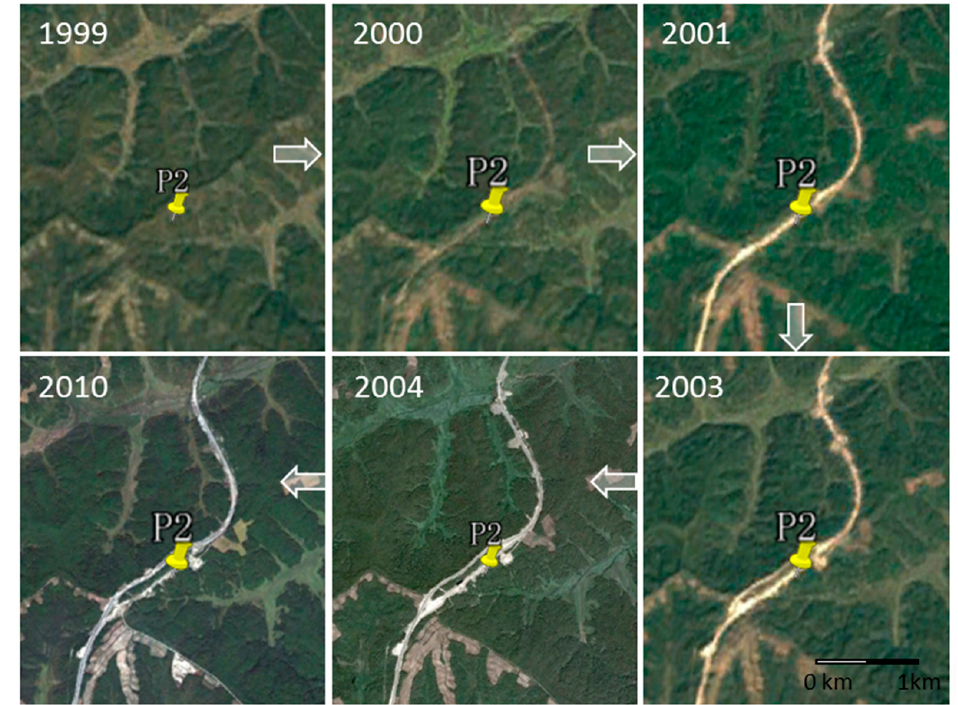
Figure 11. Historic changes of the Bei’an – Heihe expressway (Landsat images).